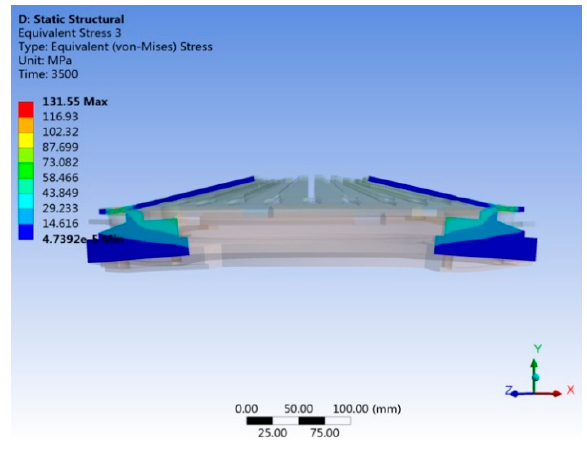
Figure 14. Stress distribution of pressure plate under constraint 2.